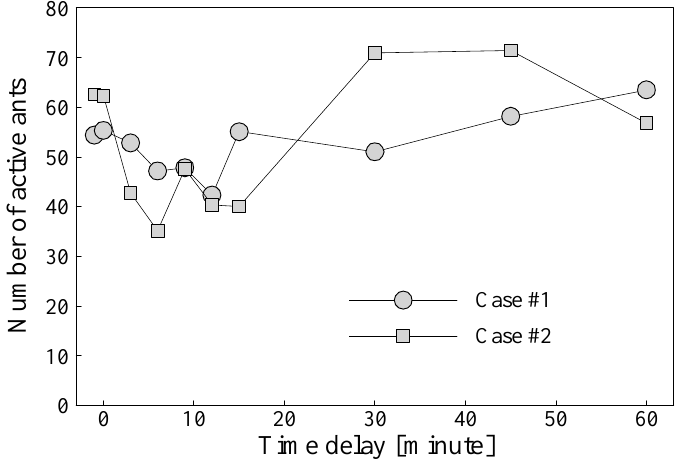
Figure 9. Number of active ants in two test cases during one-hour test